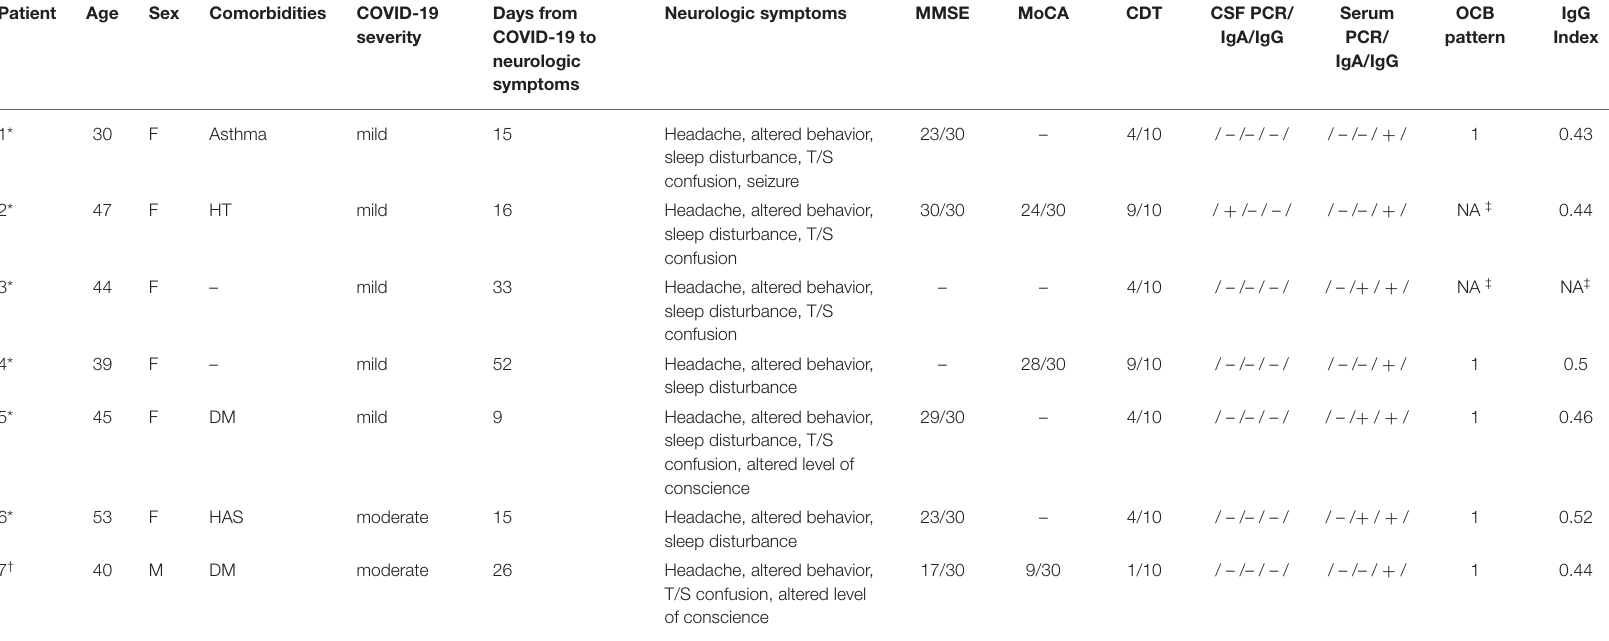
MMSE, mini-mental state examination; MoCA, montreal cognitive assessment; CDT, clock drawing test; OCB, oligoclonal bands; HT, hypertension; DM, diabetes mellitus; T/S, time and space; NA, not applied. * > 8 scholar years; † < 4 scholar years; ‡ not enough sample to proper perform the test; OCB patterns: 1 no OCBs seen, 2 OCBs in CSF only, 3 identical OCBs in CSF and serum with extra in CSF, 4 identical OCBs in both, 5 ladder OCBs. IgG index cut off < 0.7. CDT points range from 1 to 10. COVID-19 severity is defined according to